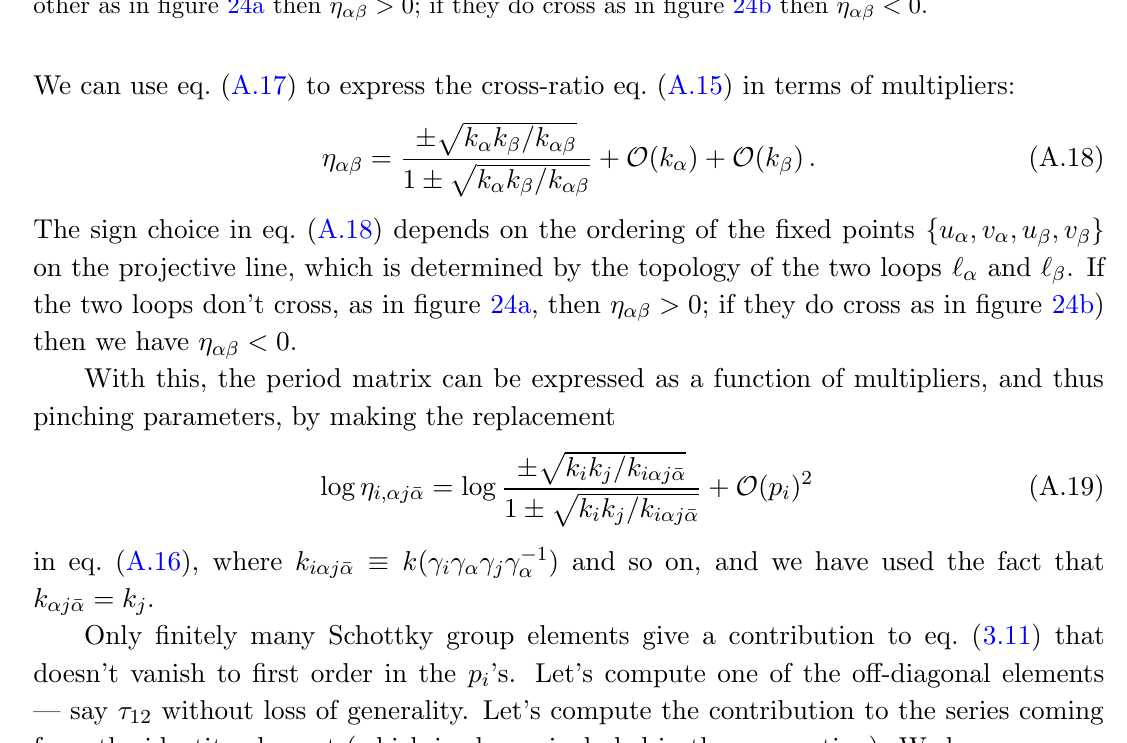
Figure 24. Ignoring all the other loops and external edges, if two loops ‘ (cid:11) , ‘ (cid:12) don’t cross each other as in (cid:12)gure 24a then (cid:17) (cid:11)(cid:12) > 0; if they do cross as in (cid:12)gure 24b then (cid:17) (cid:11)(cid:12) <